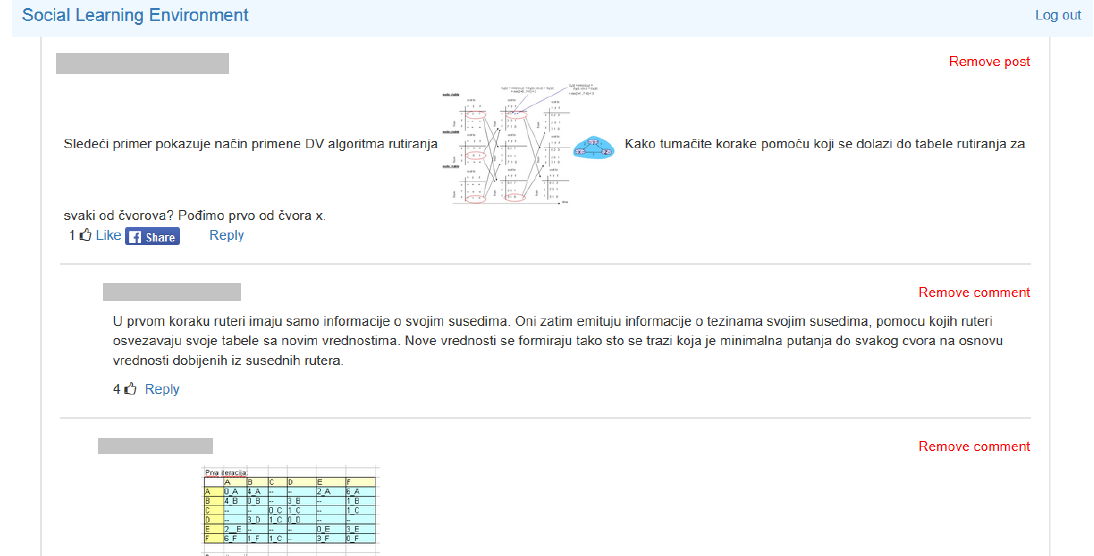
Figure 3. Example of a solved and discussed problem by a group of students in a blended classroom